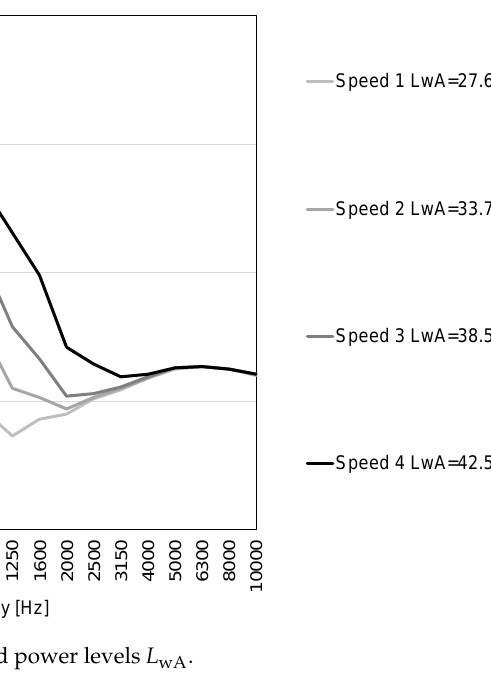
Figure 8. RAMSETE 3D model. The A-weighted sound power levels in a semi-anechoic chamber in accordance with the ISO 3744 standard were measured (Figures 9 and 10).